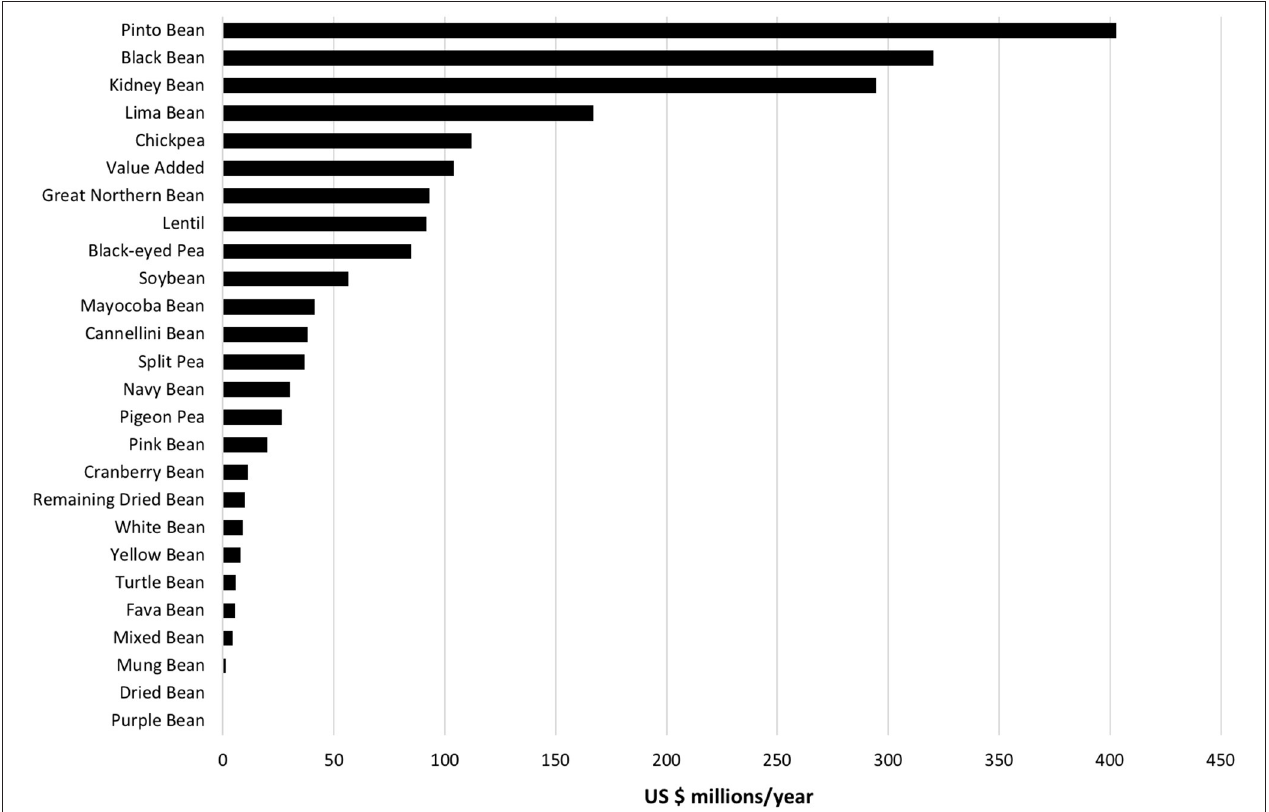
FIGURE 1 | Annual expenditure on types of legumes in the US based upon Nielsen retail grocery scanning data, average over 2017–2019